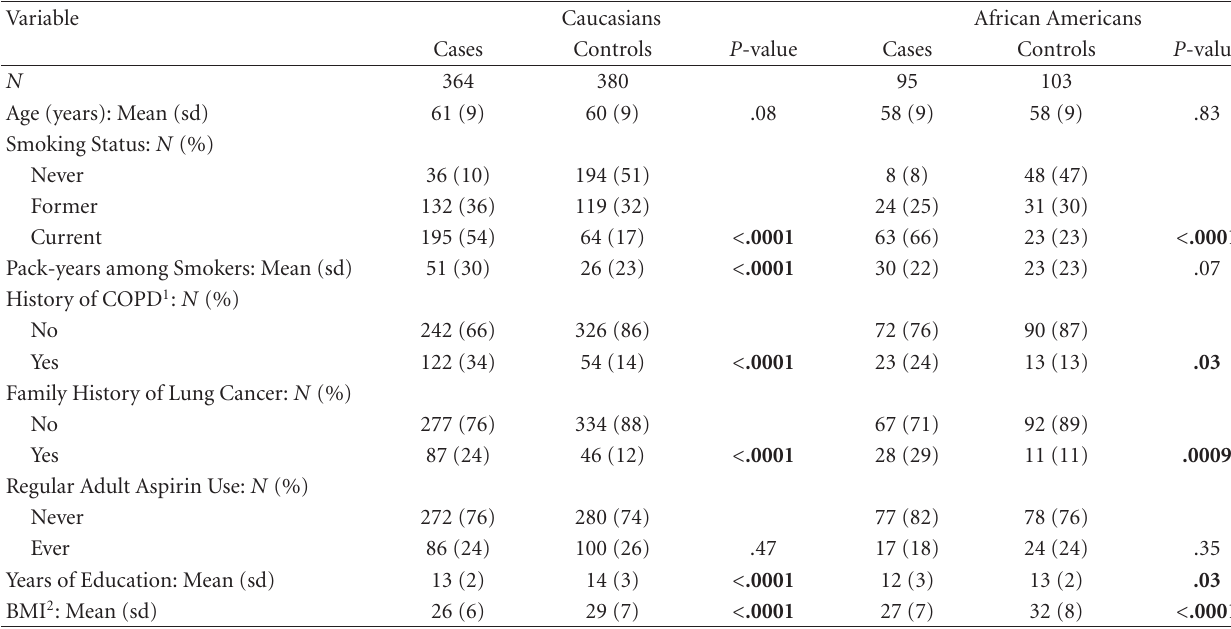
Table 1: Participant